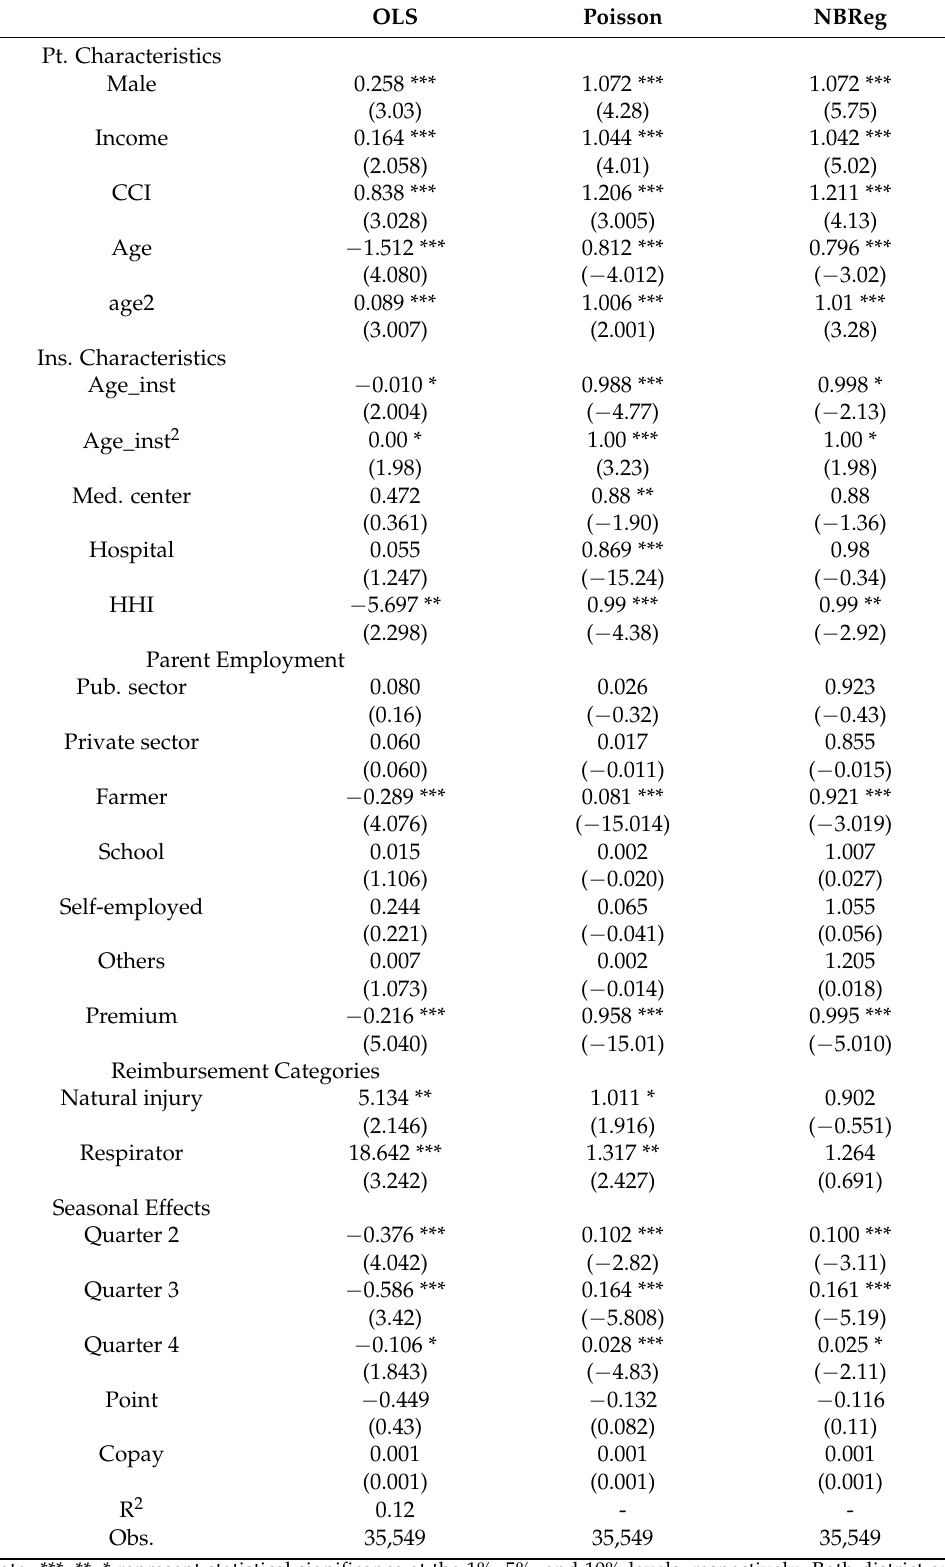
Table 3. Regression Analyses of Number of Physician Visits of Patients–Patient-level